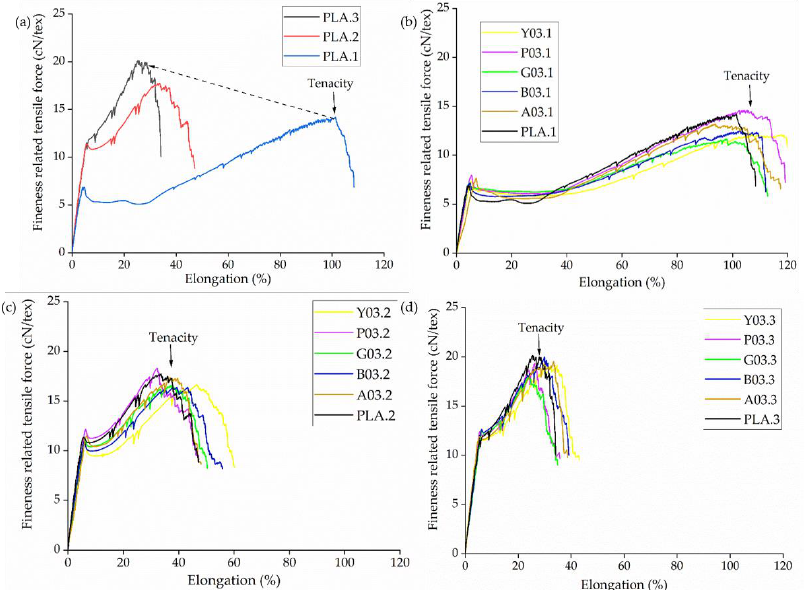
Figure 9. Tensilegrams of PLA and dyed yarns containing 0.3% ( w / w ) of each colorant at different SSD ratios. ( a ) Mean values of PLA yarns drawn at different SSD ratios. ( b – d ) Mean values of PLA and dyed yarns containing 0.3% ( w / w ) of each colorant drawn at SSD ratios of ( b ) 1, ( c ) 2, and ( d ) 3. Data are means of n = 5 samples.